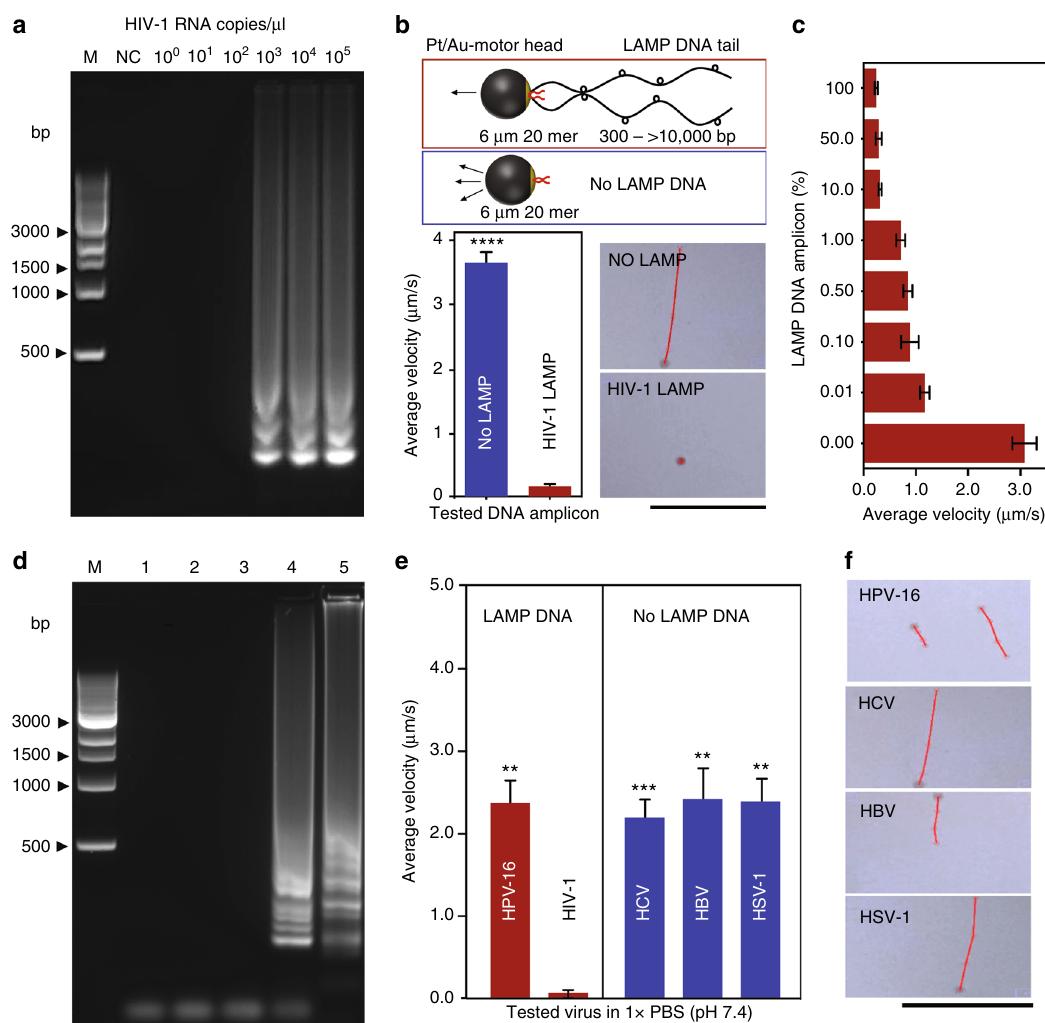
Fig. 5 Validation of the CALM system using HIV-1 LAMP amplicon. Detection sensitivity: a agarose gel electrophoresis image of serially diluted HIV-1 RNA samples (0 copies/ μ l – 10 5 copies/ μ l). Lane M: 1-kb DNA ladder marker; Lane NC: negative control (without target RNA template); b average velocity of motors ( n = 30) with (in red box) and without (in blue box) HIV-1 LAMP amplicons generated from HIV-1 RNA concentration of 10 4 copies/ μ l. The digital images show motion trajectories of motors in the presence and absence of LAMP amplicons tested in 5% H 2 O 2 (scale bar = 100 μ m); c average velocity of motors in the presence of 0% (no LAMP, control) to 100% dilutions of HIV-1 LAMP ampli fi cation products (10 4 copies/ μ l) prepared in LAMP reaction buffer. Detection speci fi city: d agarose gel electrophoresis image of HIV-1 and human papillomavirus 16 (HPV-16) and different non-targeted viruses, including hepatitis C virus (HCV), hepatitis B virus (HBV), and herpes simplex virus type-1 (HSV-1); Lane M: 1-kb DNA ladder marker; Lane 1: HSV-1; Lane2: HBV; Lane 3: HCV; Lane 4: HIV-1; Lane 5: HPV-16; e average velocity of motors ( n = 30) in the presence of the ampli fi cation products of the target and non-target viruses; f representative digital images show the motion trajectories of motors in the presence of LAMP ampli fi cation products generated with the target and non-target viruses (scale bar = 100 μ m). The concentration of the nucleic acid of all of the tested viruses was adjusted to 10 4 copies/ μ l before LAMP ampli fi cation. The results are expressed as the average values of three independent experiments. Error bars represent standard deviations. ** P < 0.01, *** P < 0.001, **** P < 0.0001 versus the corresponding group with the target HIV-1, calculated using unpaired t detection using PBS (1× PBS, pH 7.4) and serum samples spiked with HIV-1 and patient plasma samples (Fig. 6 and Table 2). The developed system can qualitatively differentiate between samples with viral loads below (i.e., negative sample) and above (i.e.,